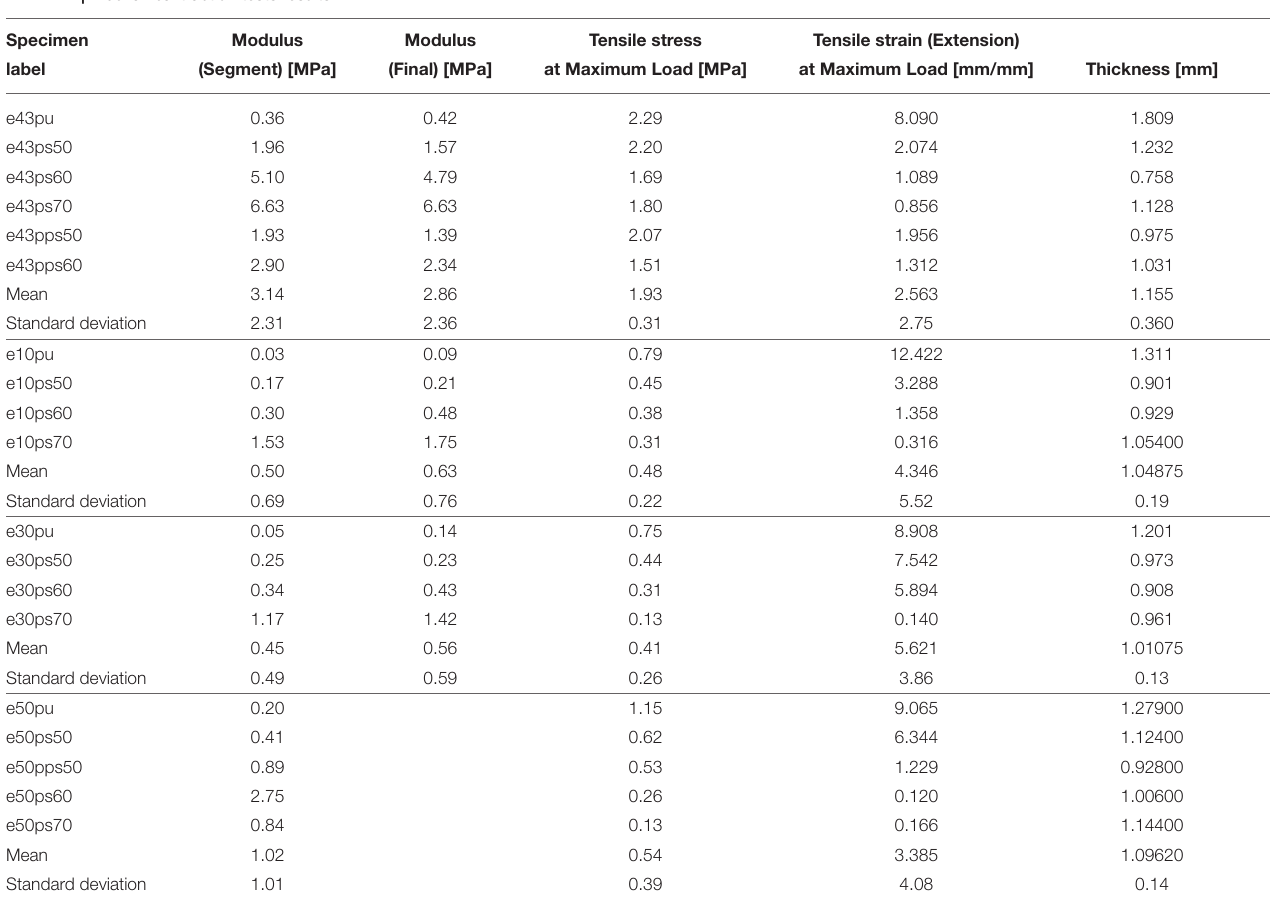
TABLE 2 | Mechanical traction tests results. Specimen Modulus Modulus Tensile stress Tensile strain